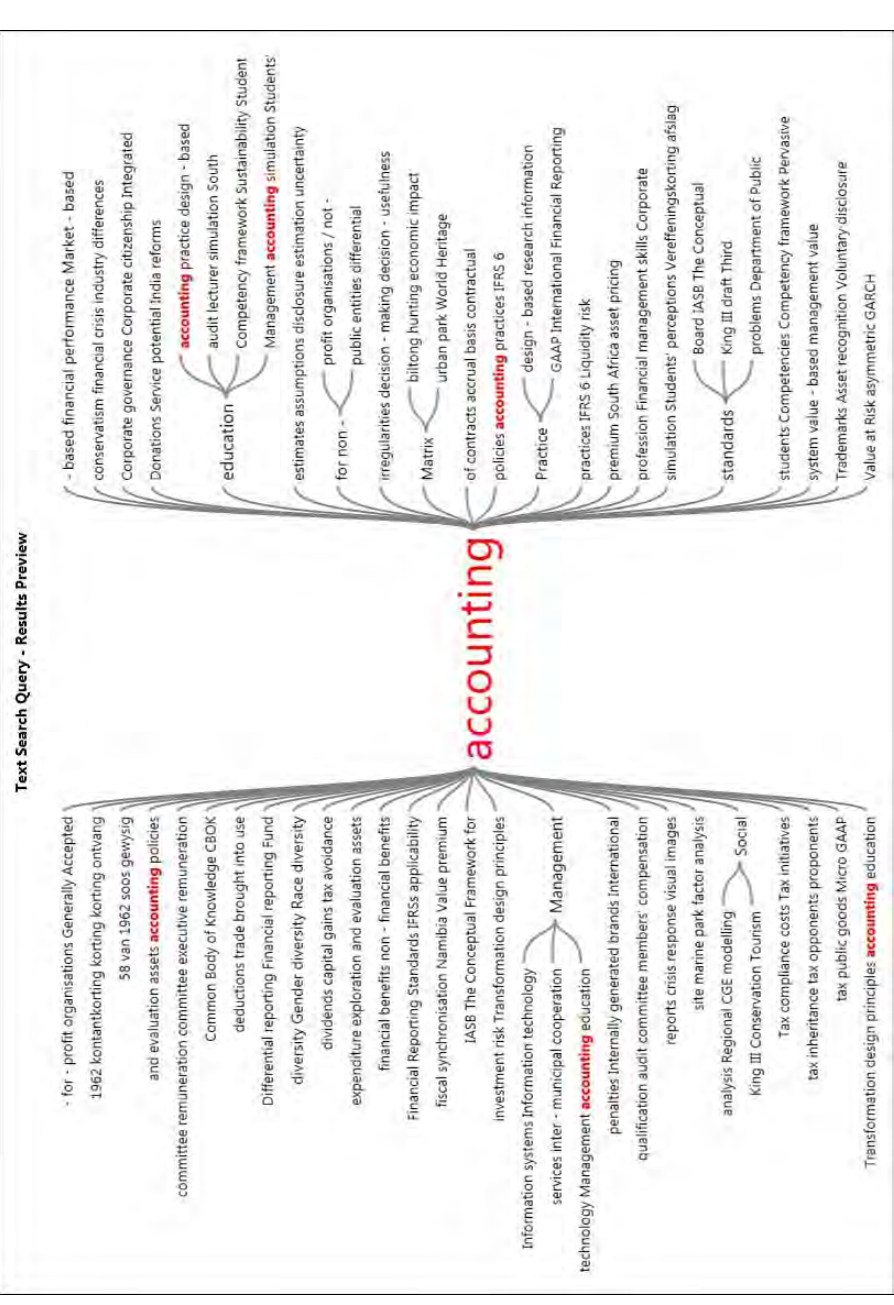
FIGURE 4: Word Tree Diagram: ‘Accounting’ Source: